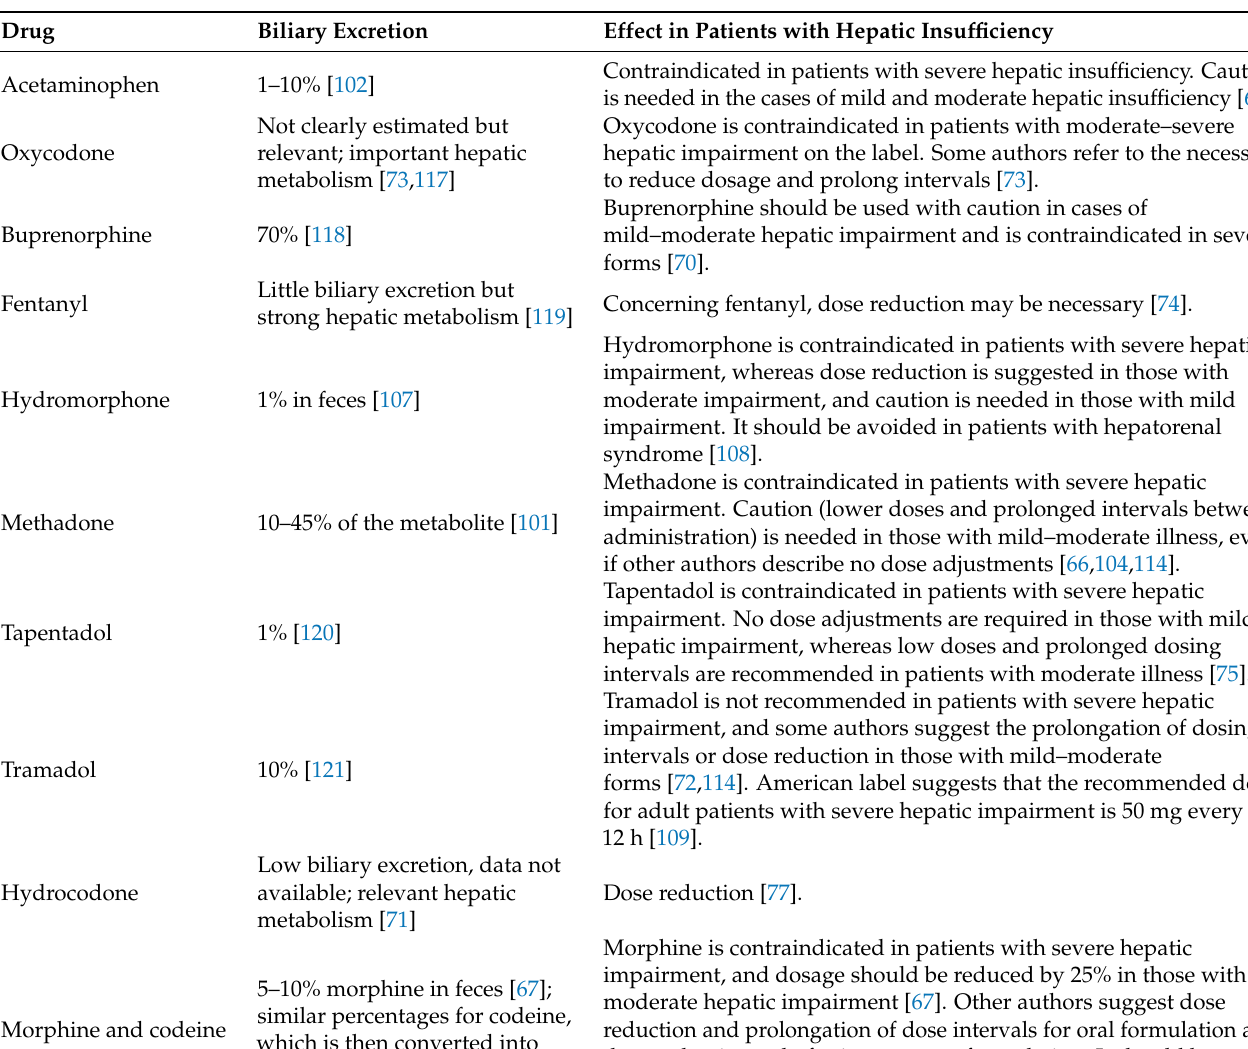
Table 5. Effects of analgesic drugs in patients with hepatic